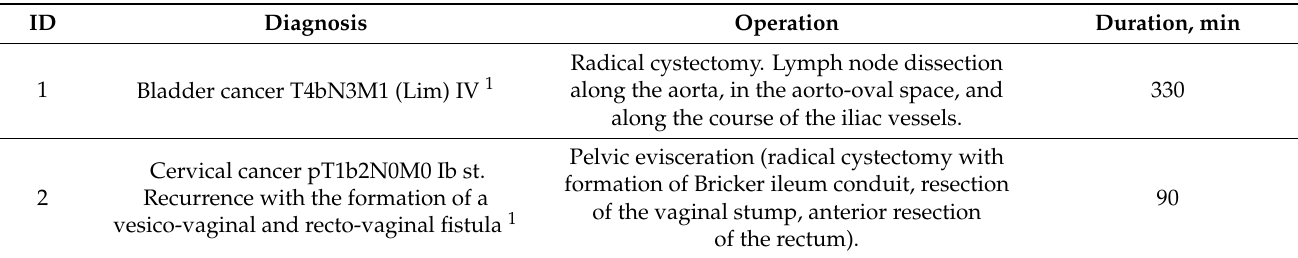
Table 2. Patients with noninvasive (on-skin) fixation of marks.